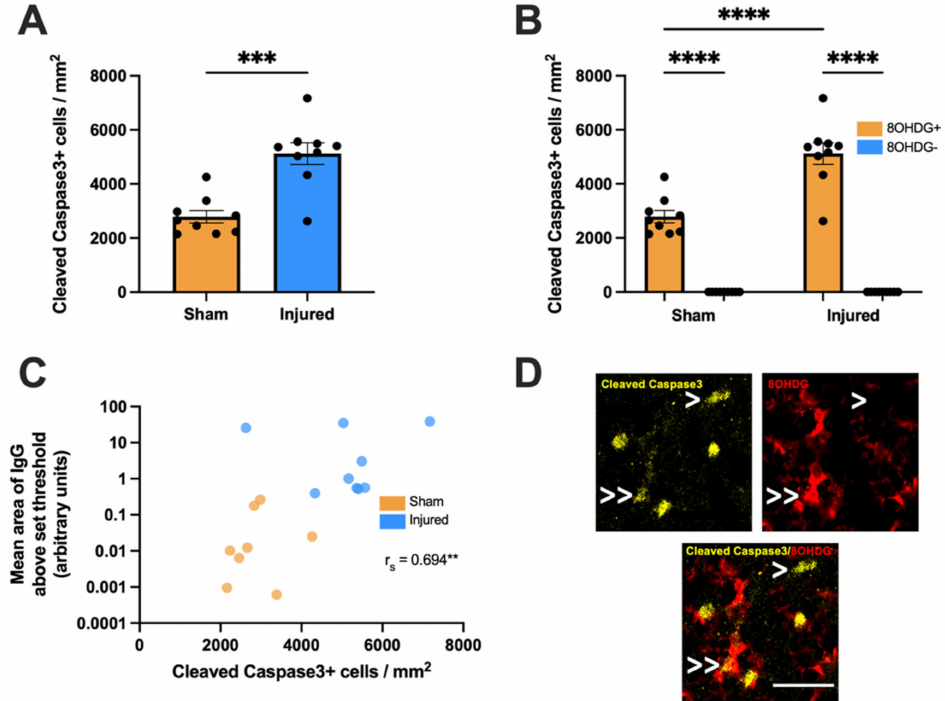
Figure 3. Effect of injury on apoptosis within the ventral optic nerve. ( A ) The density of Cleaved Cas- pase3+ cells was quantified in the ventral optic nerve following partial optic nerve transection or sham injury. Graphs display individual data points overlaid on a bar displaying the mean ± SEM. n = 9 rats per group. Statistical analysis by t -test. ( B ) The relative densities of Cleaved Caspase3+ 8OHDG+ and Cleaved Caspase3+ 8OHDG − cells were quantified. Statistical analysis by two-way ANOVA and Tukey post hoc tests. Graphs display individual data points overlaid on a bar displaying the mean ± SEM. n = 9 rats per group. ( C ) The area of IgG immunointensity was correlated to the density of Cleaved Caspase3+ cells using Spearman’s correlation, with the r s value and corresponding p -value displayed on the graph. The mean area of IgG immunointensity was plotted on a log scale to best illustrate the overall relationship between IgG and Cleaved Caspase3+ on the scatterplot. Each data point on the graph represents an individual animal. n = 8–9 rats per group. ( D ) Representative image of both a Cleaved Caspase3+ 8OHDG+ cell (indicated by >>) and a Cleaved Caspase3+ 8OHDG − cell (indicated by >) is shown, scale bar = 25 µ m. No outliers were removed for any outcome measure. Significant differences are indicated by ** p ≤ 0.01, *** p ≤ 0.001, **** p ≤